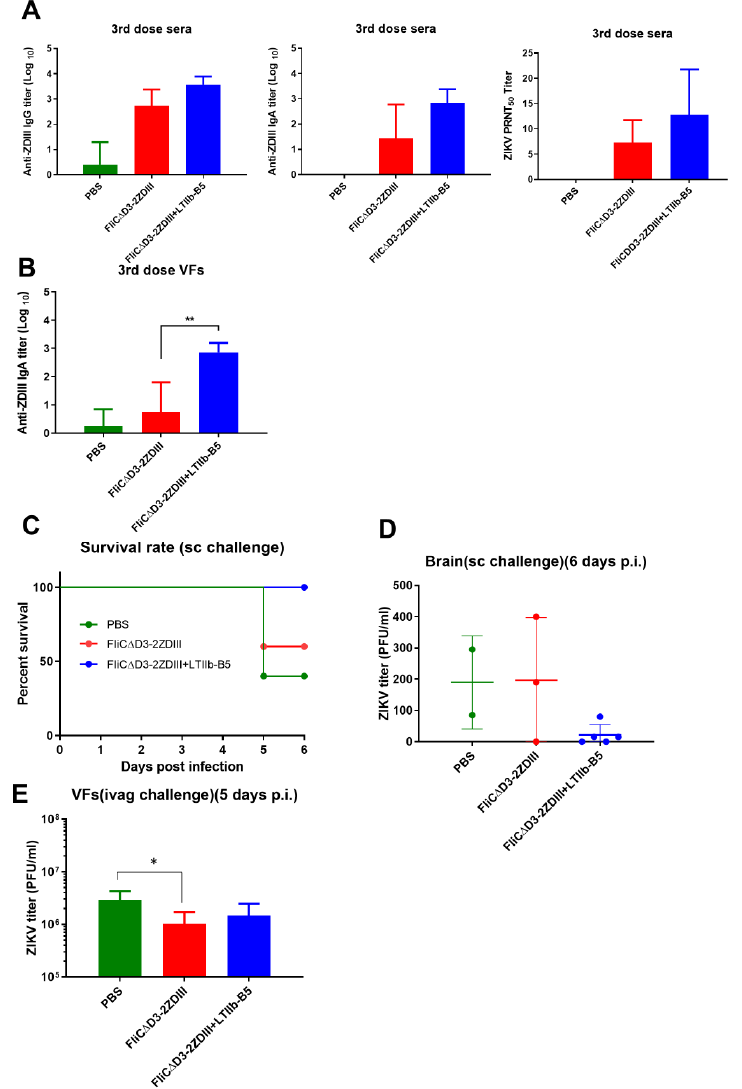
Figure 7. Immune responses and protection of the second ‐ generation FliC Δ D3 ‐ 2ZDIII antigen plus LTIIb ‐ B5 adjuvant. ( A ) Groups of BALB/c mice (n = 5 per group) were intranasally immunized with (i) three doses of 40 μ g FliC Δ D3 ‐ 2ZDIII, (ii) 40 μ g FliC Δ D3 ‐ 2ZDIII plus LTIIb ‐ B5 adjuvant, (iii) the first and second dose priming with 10 8 pfu Ad ‐ ZprME vector, followed by a third dose booster of 40 μ g FliC Δ D3 ‐ 2ZDIII plus LTIIb ‐ B5 adjuvant, alone with the PBS ‐ immunized control group. Sera and VFs were collected at week 8. Subcutaneous (SC) or intravaginal (IVAG) challenges with 10 8 PFU of ZIKV were conducted at week 9. The anti ‐ ZDIII IgG, IgA, and neutralizing antibody titers (PRNT ‐ 50) in sera. ( B ) The anti ‐ ZDIII IgA titer in VFs; ( C ) Survival rates recorded for 6 days; ( D ) The virus titer in brain at day 6 after SC challenge; ( E ) The virus titer in VFs determined at day 5 after IVAG challenge. Multiple group comparison was analyzed in all groups except the PBS group in ( A , B ). Multiple group comparison was analyzed in all groups. Data were analyzed using one-way ANOVA with Tukey’s or Holm-Sidak’s multiple comparison tests. (*, p < 0.05, **, p < 0.01). Error bars are plotted as standard deviation from the mean